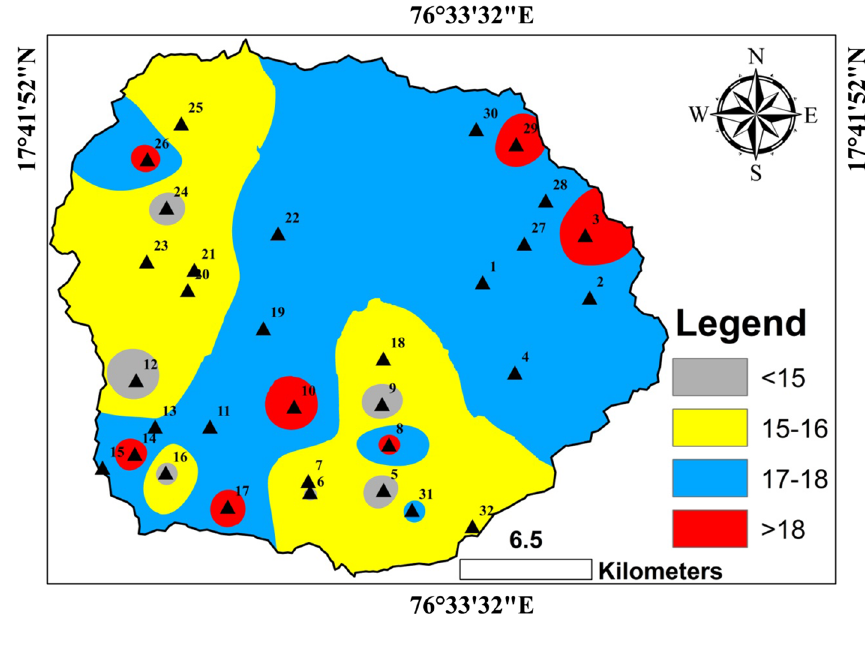
Fig. 15 Geospatial distribution of potassium